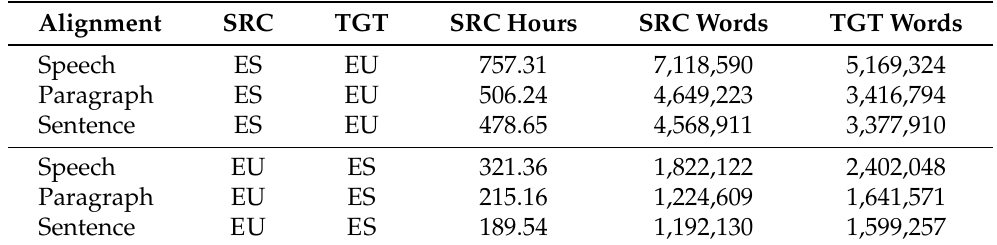
Table 4. Filtered data statistics after each alignment step. Speech indicates the figures for identified speech in the original content; Paragraph indicates the figures after alignment at the paragraph level; Sentence indicates the figures after alignment at the sentence level.